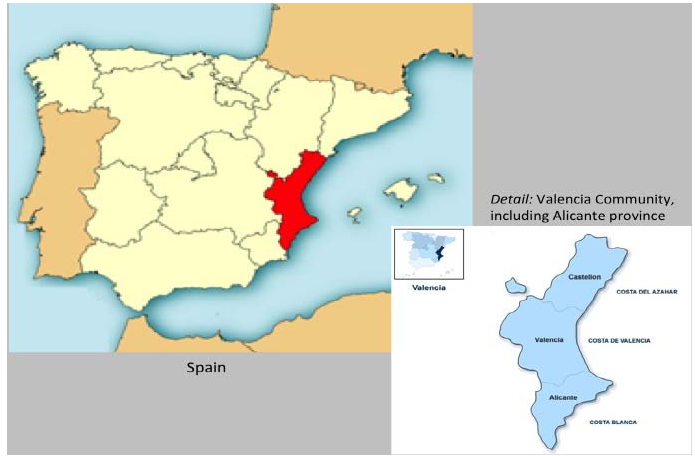
Note: Courtesy of Wikimedia Commons